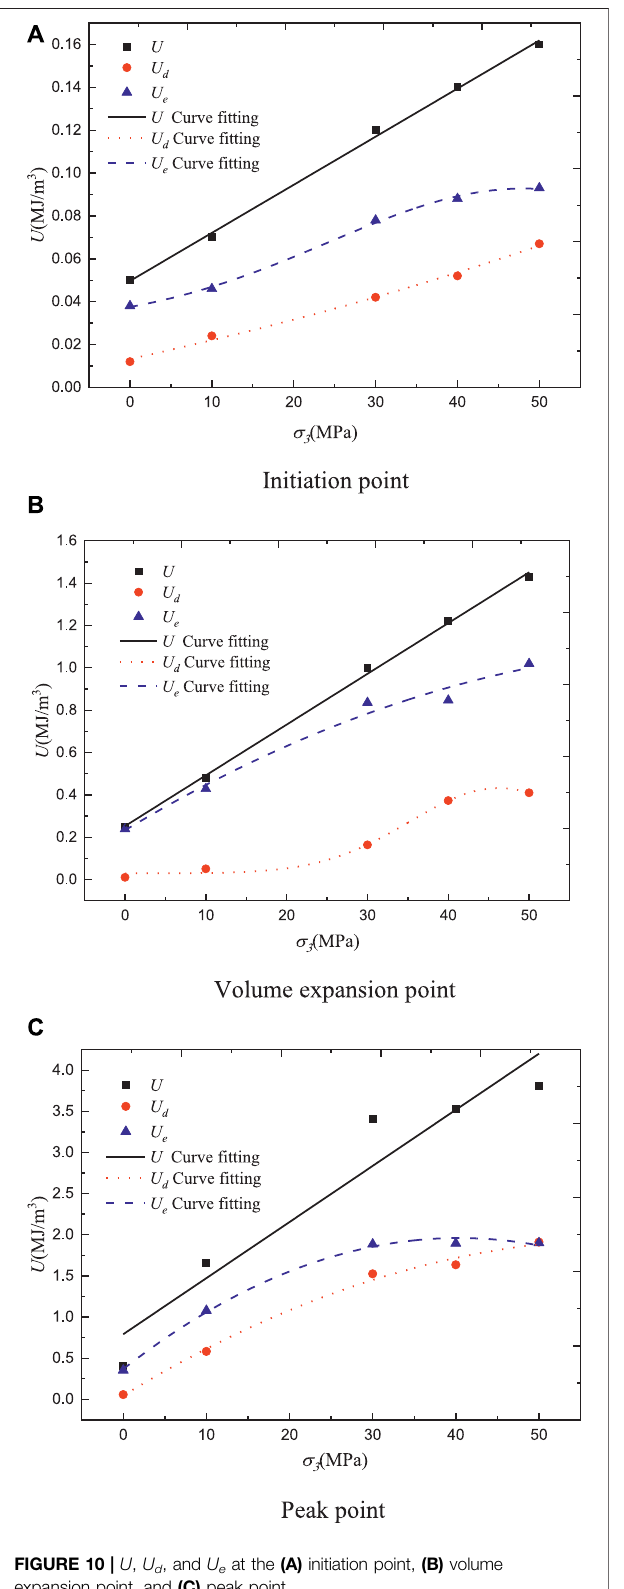
FIGURE 10 | U , U d , and U e at the (A) initiation point, (B) volume expansion point, and (C) peak point.